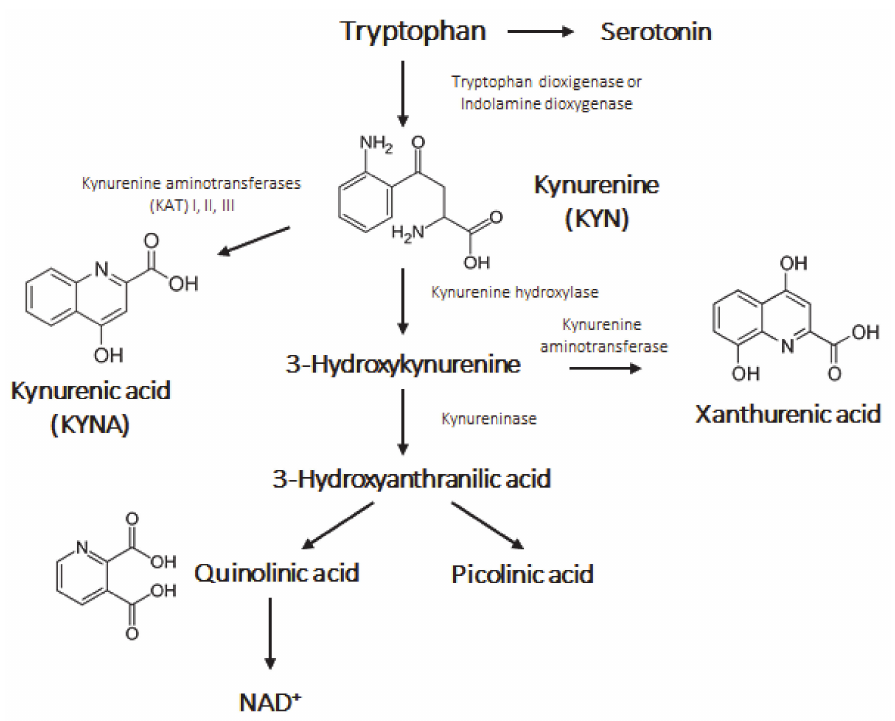
Figure 1. The kynurenine pathway